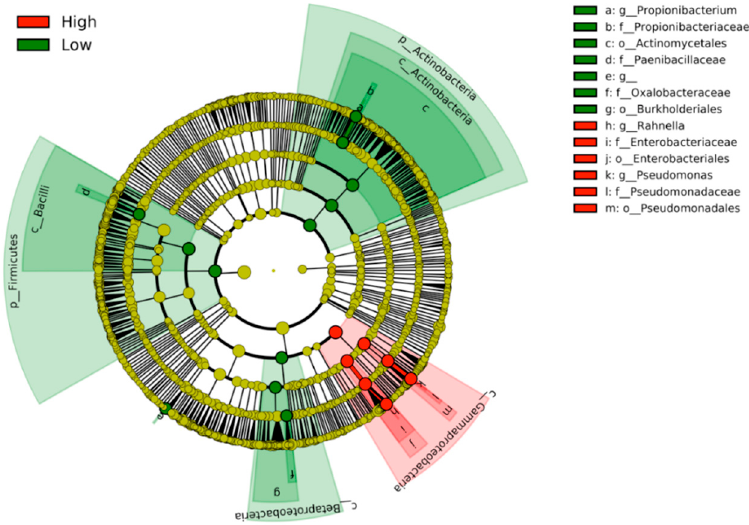
Figure 4. Cladogram showing the distribution of the clades correlated with the High monocyte activity (red) and the Low activity (green). The High-activity clades are clustered within the class Gammaproteobacteria .